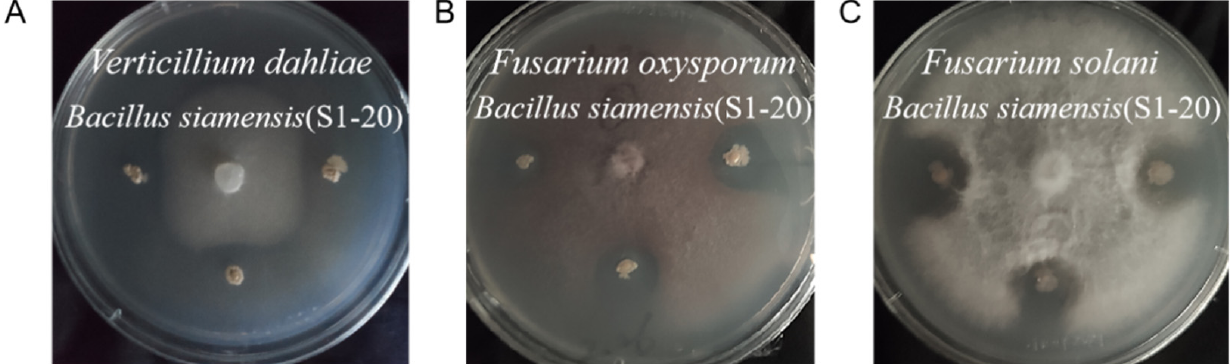
Figure 7. Exhibition of antagonistic effects of endophytic bacterial isolate S1-20 against pathogenic fungi (( A ): Verticillium dahliae , ( B ): Fusarium oxysporum , and ( C ): Fusarium solani ).